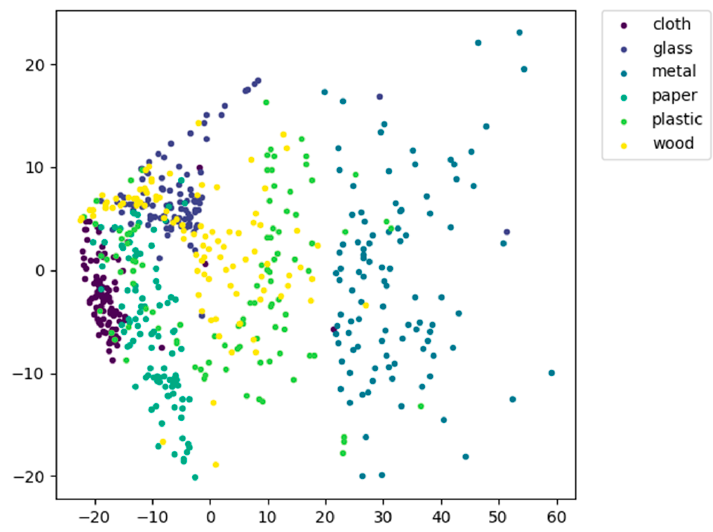
Figure 13. Data distribution of six material classes.